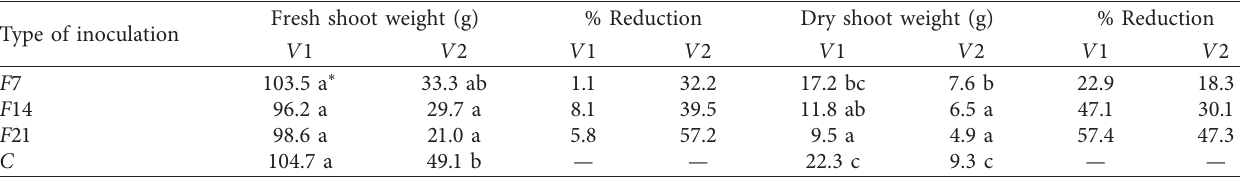
F 7 � fungus inoculated 7 days after seedling emergence, F 14 � fungus inoculated 14 days after seedling emergence, F 21 � fungus inoculated 21 days after seedling emergence, and C � control (uninoculated); V 1 � Essoumtem and V 2 � Clemson spineless. ∗ Followed by the same letter in a column are not significantly different at LSD ( P < 0 . 05). Table 6: Fresh and dry root weights for “Essoumtem” and “Clemson spineless” under four inoculations in field experimentation. Fresh root weight (g) Type of inoculation